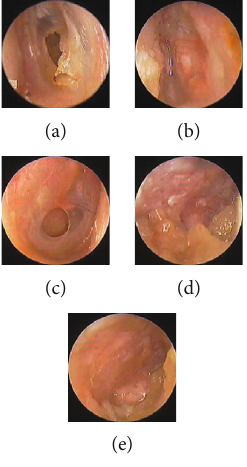
Figure 6: Underlay myringoplasty with perichondrium graft. Preoperative perforation (a) and the perforation at 2 weeks postoperatively (b) in a 33-year-old woman with a 2-year history of a traumatic perforation. Preoperative perforation (c) and the perforation at 3 weeks (d) and 4 weeks (e) postoperatively in a 51- year-old woman with COM.